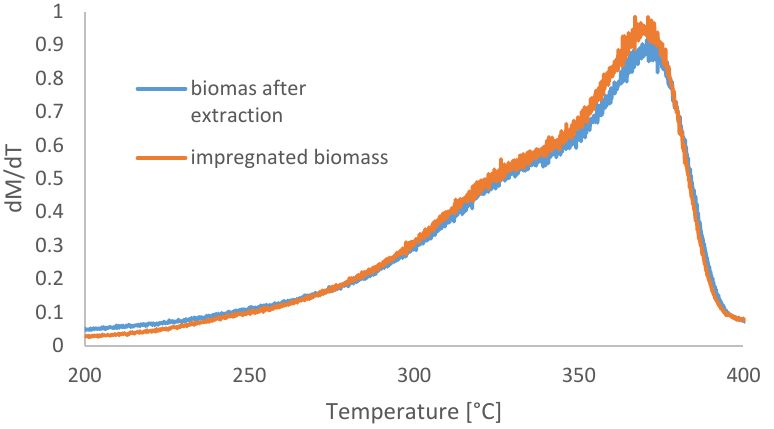
Figure 4. TGA analysis of crude railroad ties and samples of the railroad after extraction.